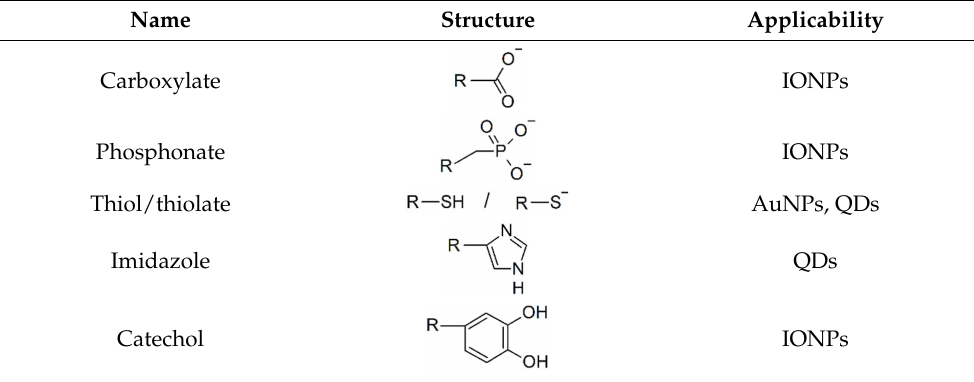
Table 1. Name, structure and material compatibility of the main anchoring function using in the surface chemistry of